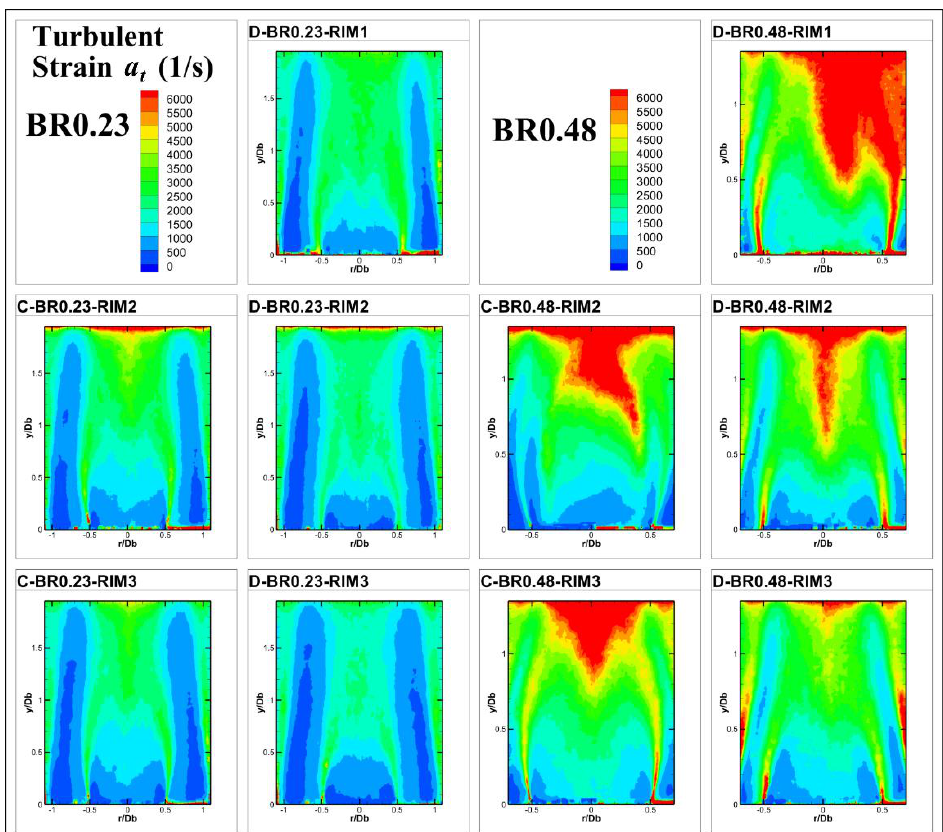
Figure 11. Contours of turbulent strain rate for the examined cases.